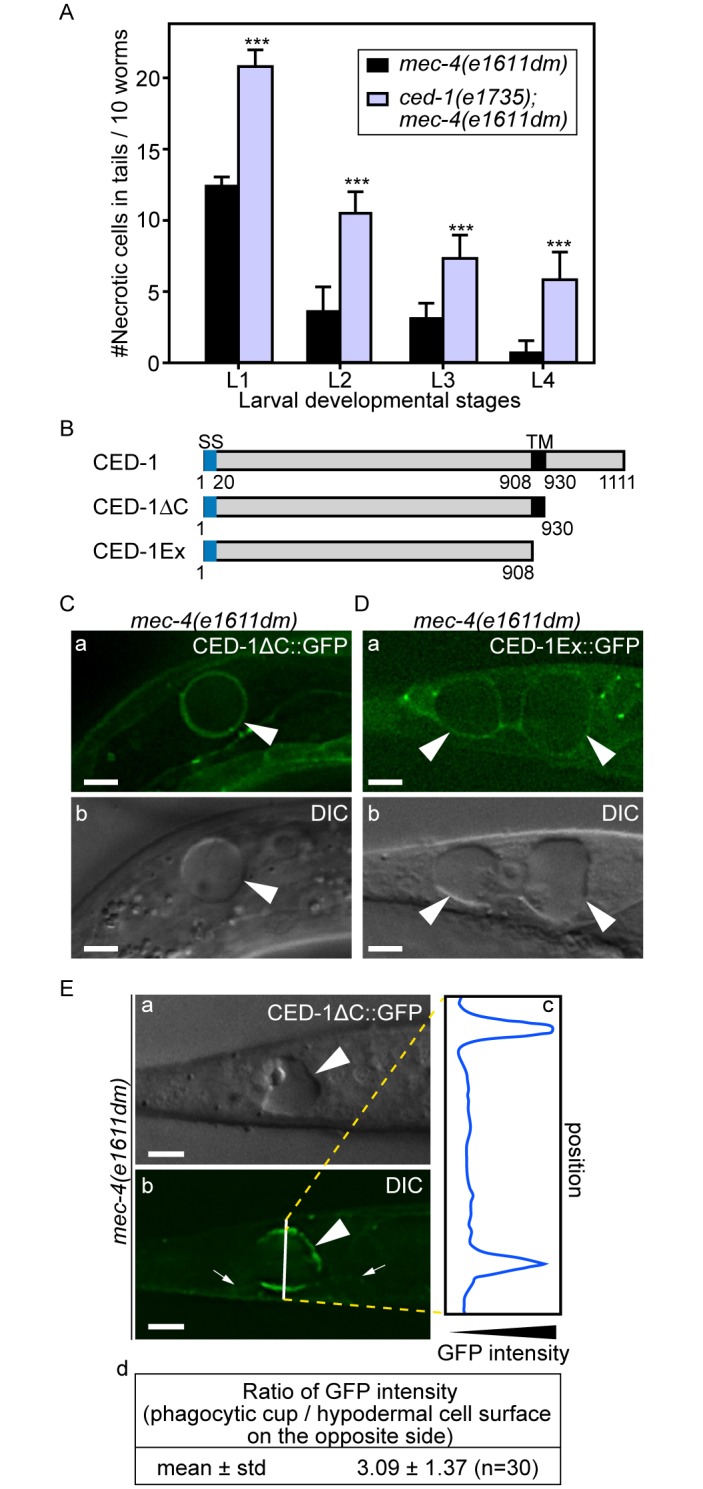
Necrotic cells are recognized by phagocytic receptor CED-1.(A) Inactivating ced-1 perturbs the removal of necrotic cells. Worms of indicated genotypes in four larvae stages were scored for the number of necrotic corpses in the tail. For each data point, 3 groups of 20 animals per group were scored. Data are presented as mean ± sd. ***, p<0.001, Student t-test. (B) Domain structures of CED-1 and its truncated forms. Numbers indicate the beginning and ending residues of each domain. SS, signal sequence. TM: transmembrane domain. (C-D) CED-1ΔC::GFP (C) and CED-1Ex::GFP (D) expressed in engulfing cells cluster around necrotic cells. Epifluorescence (a) and corresponding DIC (b) images of CED-1ΔC::GFP(C) or CED-1Ex::GFP (D) expressed in hypodermal cells under the control of Pced-1 in the mec-4(e1611dm) background. Arrowheads mark necrotic cells on which GFP clusters around. Dorsal is to the top. Scale bar are 5μm. (E) Quantitative comparison between the signal intensity of CED-1ΔC::GFP on a phagocytic cup (arrowhead) engulfing an necrotic cell (arrowheads) and on the side (small arrows) of the engulfing cell opposite to the phagocytic cup. (a-b) Epifluorescence (a) and corresponding DIC (b) images of the tail of an L1-stage larva expressing CED-1ΔC::GFP in the hypodermal cells. One white vertical line in (b) is where quantitative line profile of GFP intensity shown in (c) is generated. Dorsal is to the top. Scale bars are 6μm. (c) The GFP signal intensity line profile corresponds to the white line in (b) drawn across the engulfing hypodermal cell, reaching each side of the worm’s tail. (d) For each of the thirty phagocytic cups or phagosomes containing necrotic cells, signal intensity of three random points on the surface of phagocytic cups or phagosomes were measured and averaged, so were that of three points on the side of the engulfing cell opposite to the necrotic cell being engulfed. The mean ratio of the two sets of signal intensity data and the standard deviation (std) were shown.